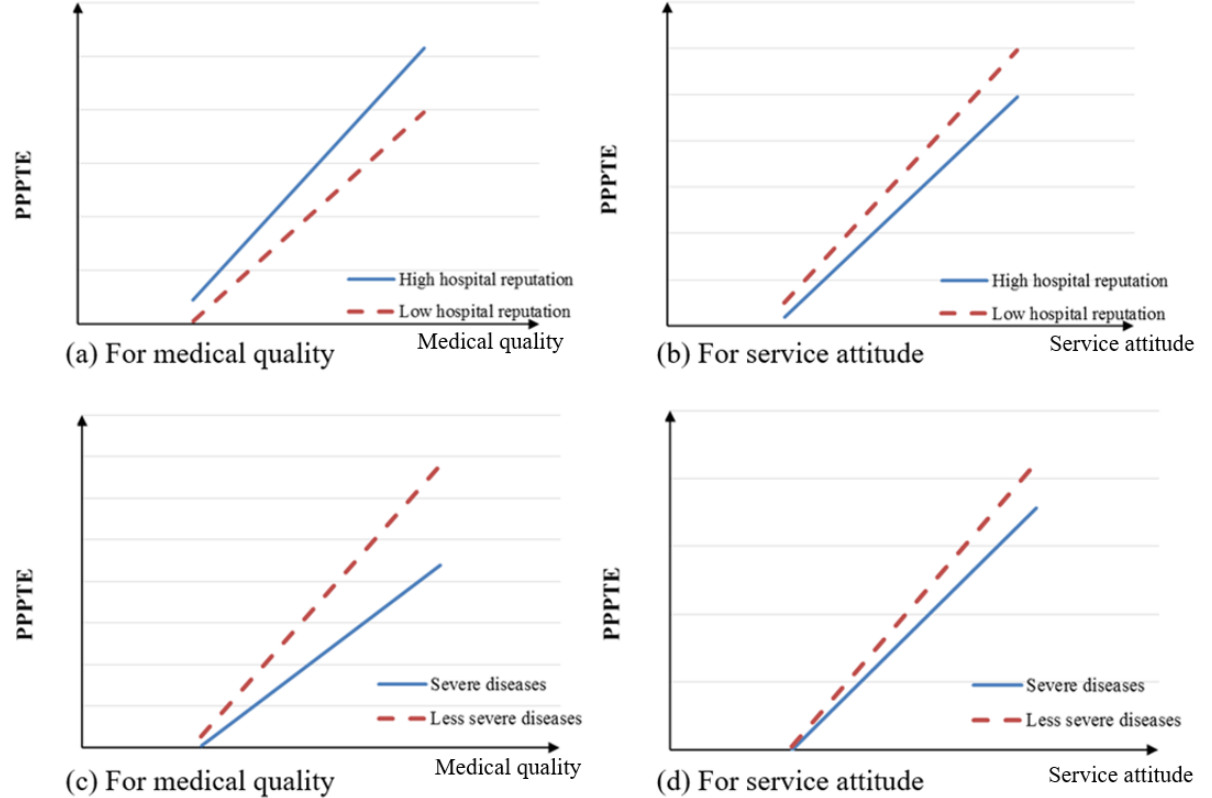
Figure 4. The moderating effects of hospitals’reputation and disease severity. PPPTE: patient propensity to post treatment